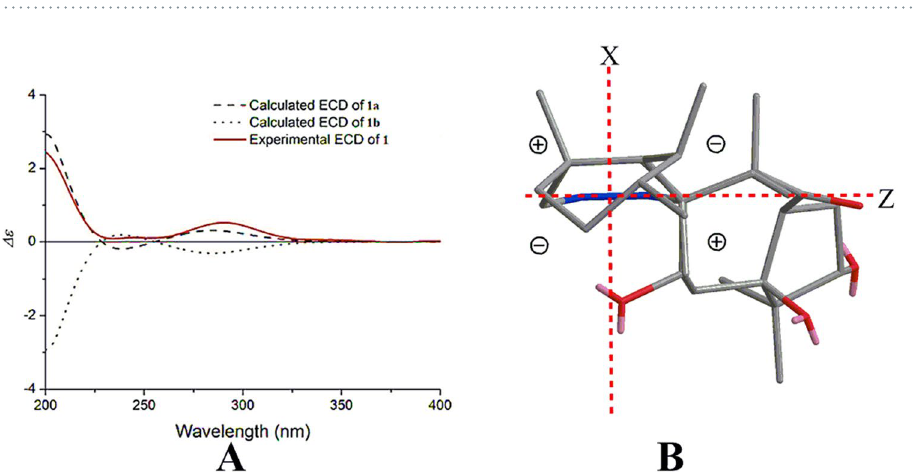
Figure 4. ( A ) Experimental ECD spectrum of 1 , using TDDFT at the B3LYP/6-31 G(d) level in MeOH calculated ECD spectra of 1a and 1b . ( B ) Application for the olefin octant rule of 1 (rear octants viewed along Y-axis).